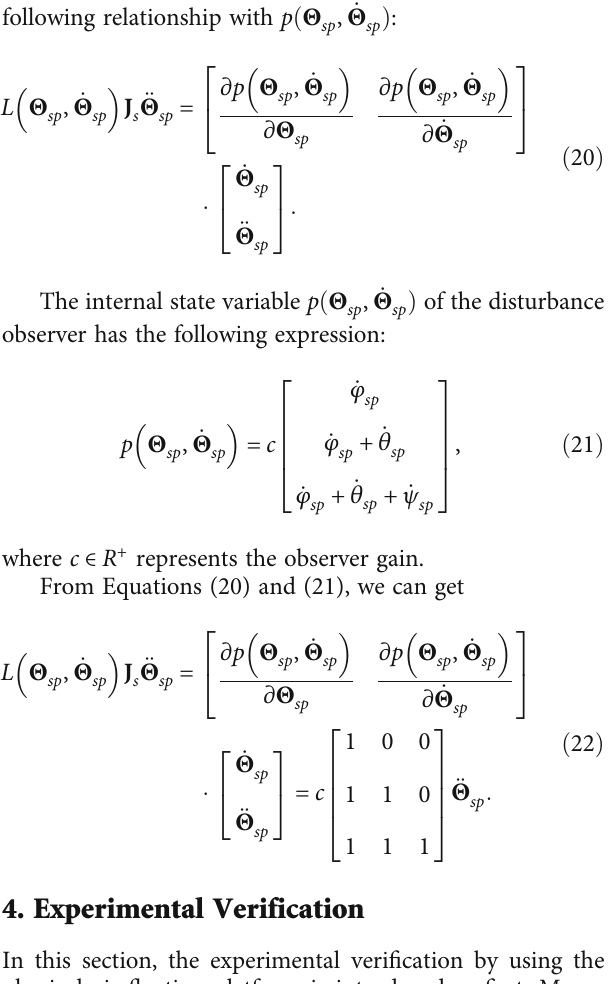
Figure 7: Relative attitude angle between two modules with PD controller.